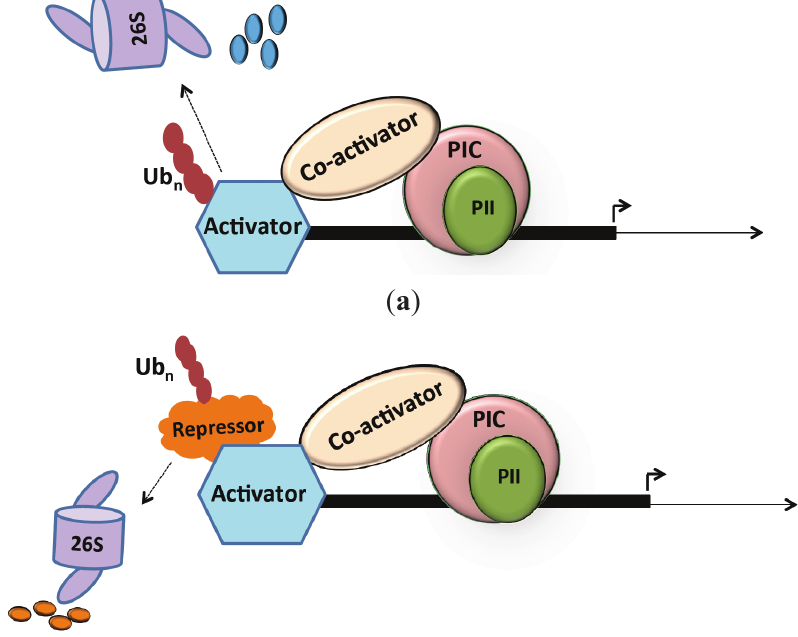
Figure 1. Proteolysis-dependent roles of the 26S proteasome in transcription